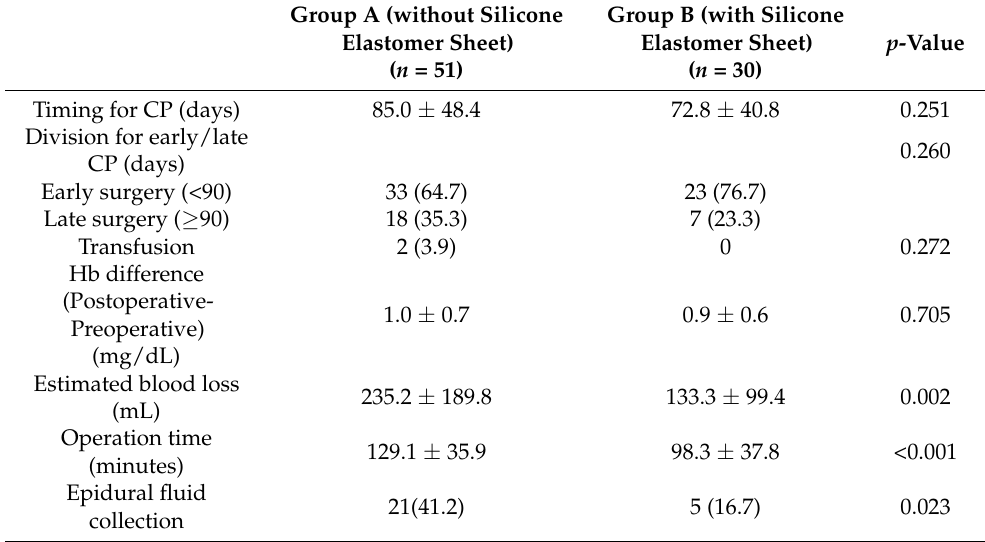
Table 3. CP results in the two